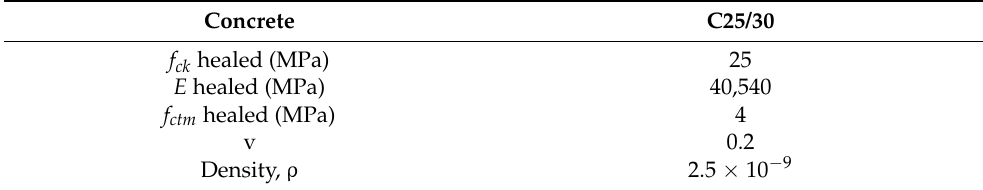
Table 4. Material properties of